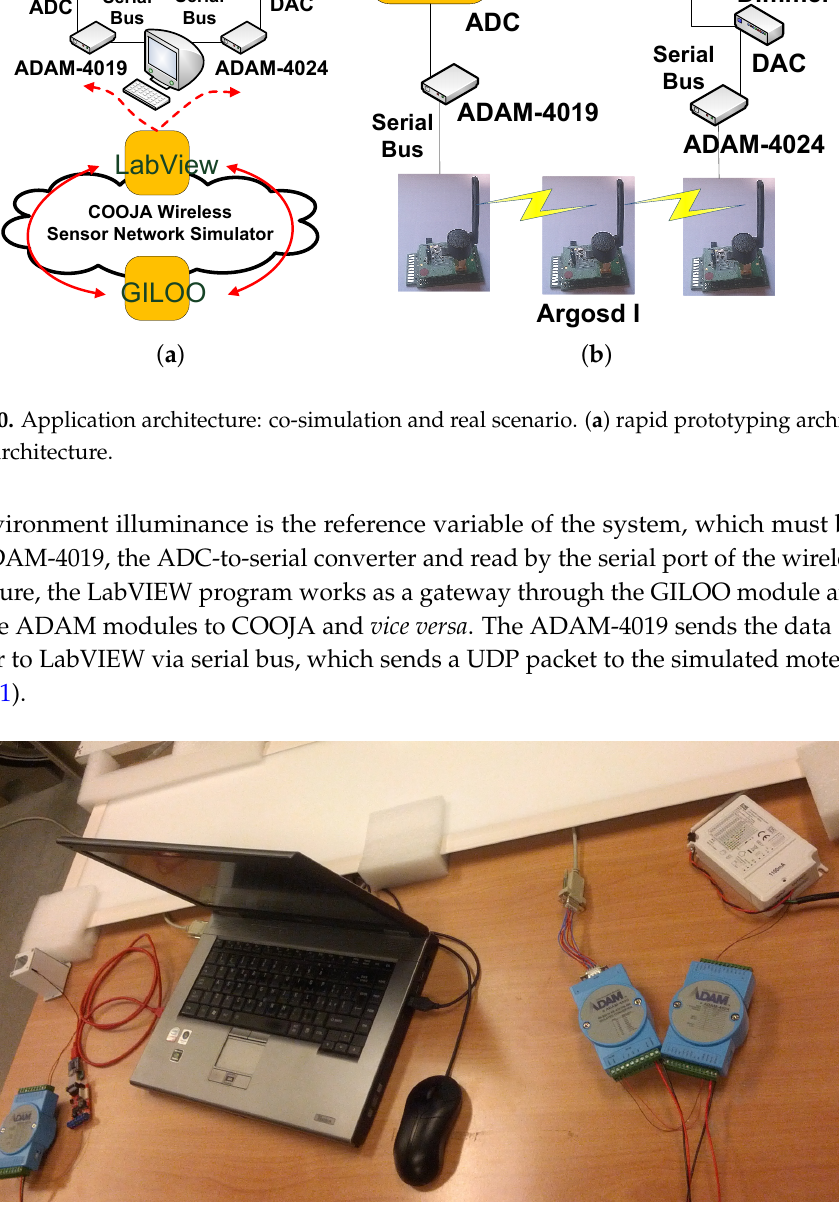
Figure 11. Experimental application